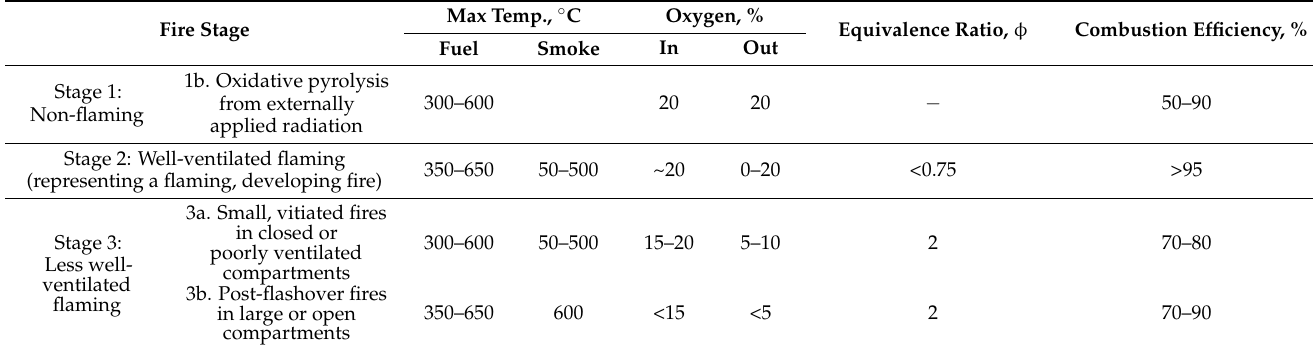
Table 1. ISO classification of fire stages, based on ISO 19706